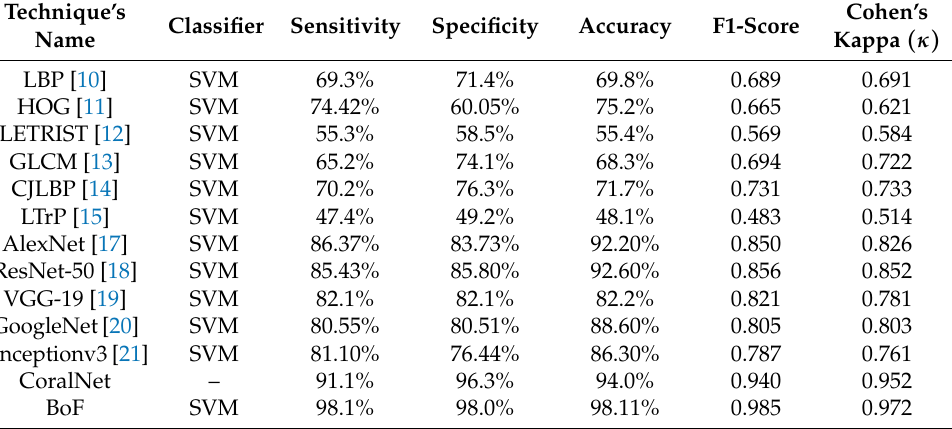
Table 4. Performance of hand-crafted descriptors and D-CNN models for third dataset (Bleached, healthy, and dead (BHD)